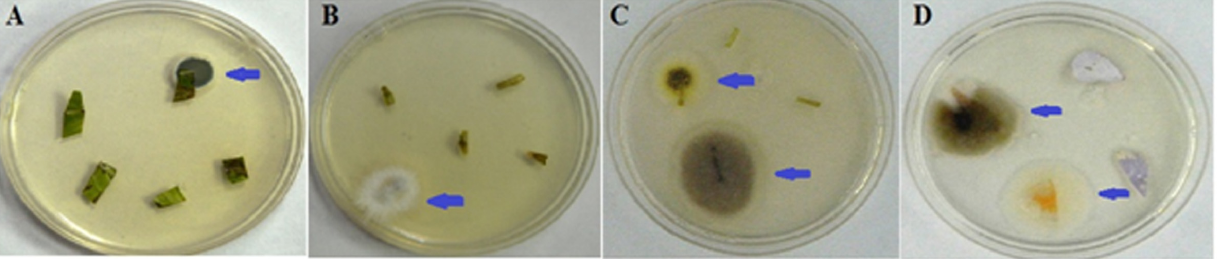
Fig 1. Isolation of endophytic fungi from C . roseus plant. Arrowheads indicate the emergence of endophytic fungi from the plant cuttings. A-leaf, B-stem, C-pedicel and D-flower petal.